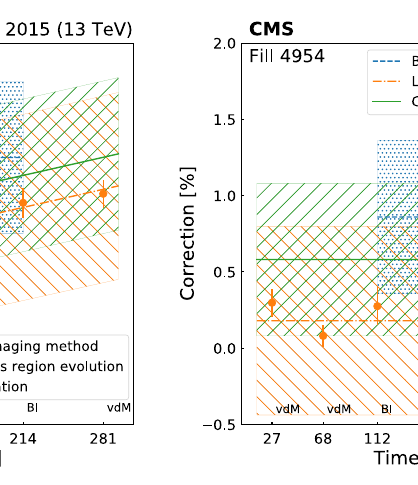
uncertainties are shown as hatched areas. Different methods (including the combination) are color coded. Each point corresponds to one scan pair in fills 4266 (left) and 4954 (right). The statistical uncertainty is shown by the error